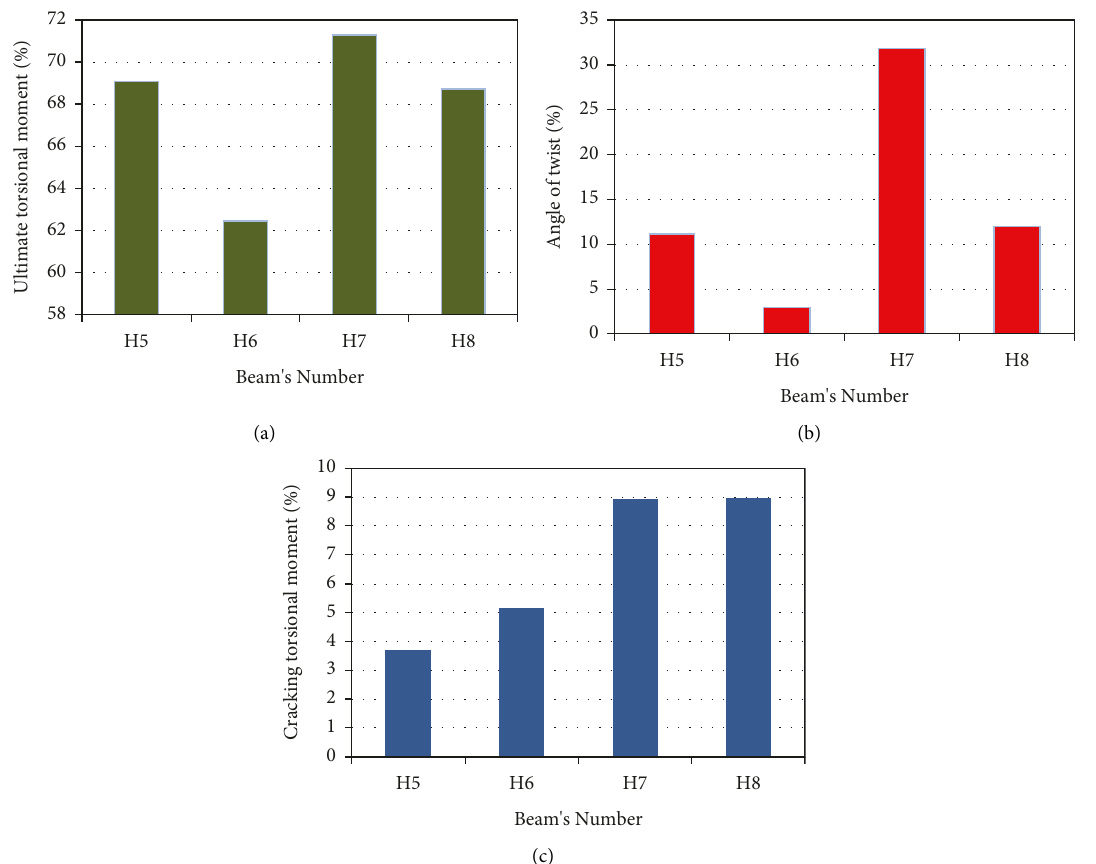
Figure 15: (a) Improvement of the Tu. (b) Improvement of the angle of twist. (c) Improvement of the Tcr.